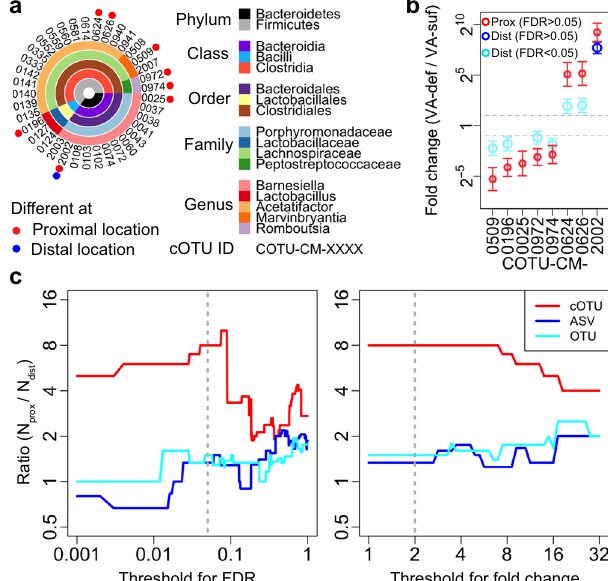
Fig. 7 Differential cell abundance of cOTUs depending on dietary vitamin A de fi ciency. a The detected cOTUs and taxonomies (predicted by the RDP classi fi er, see Methods section). The genera that included at least one differentially abundant cOTU between the VA-suf fi cient and VA-de fi cient groups at either the distal or proximal location are shown (other in Supplementary Data 8). Different, FDR < 0.05 and fold change > 2. b The estimated fold changes (dots) and standard errors (error bars, n = 4) by DESeq2 between the VA-suf fi cient group (VA-suf) and VA-de fi cient group (VA-def) of the differentially abundant cOTUs (FDR < 0.05, fold change > 2) at either distal (Dist) or proximal (Prox) location. The differential analysis of COTU-CM-0025 at the distal location was not performed since its abundances were too low (Methods section). c The ratio between the number of differentially abundant cOTUs, ASVs, or OTUs at the proximal location (N prox ) and at the distal location (N dist ) as a function of threshold for FDR (left) and for fold change (right). FDR < 0.05 and a fold change > 2 (gray dotted lines) were considered “ signi fi cant differences ” in other analyses. Source data for ( b ) and ( c ) are provided as a Source Data fi